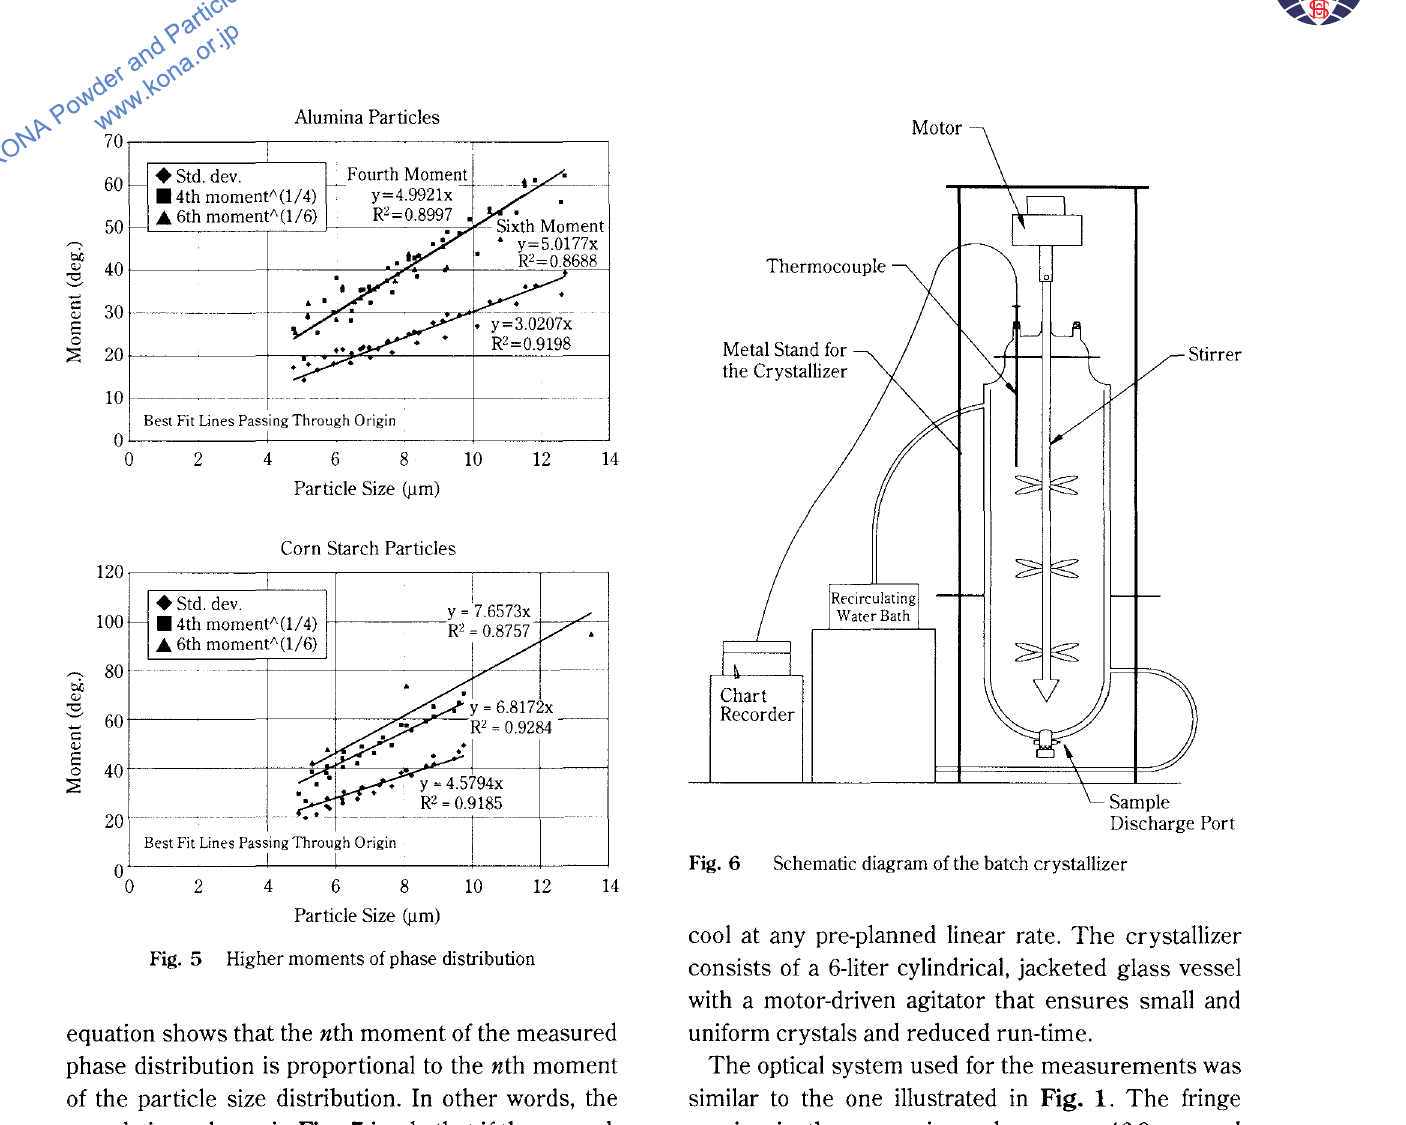
Fig. 6 Schematic diagram of the batch crystallizer